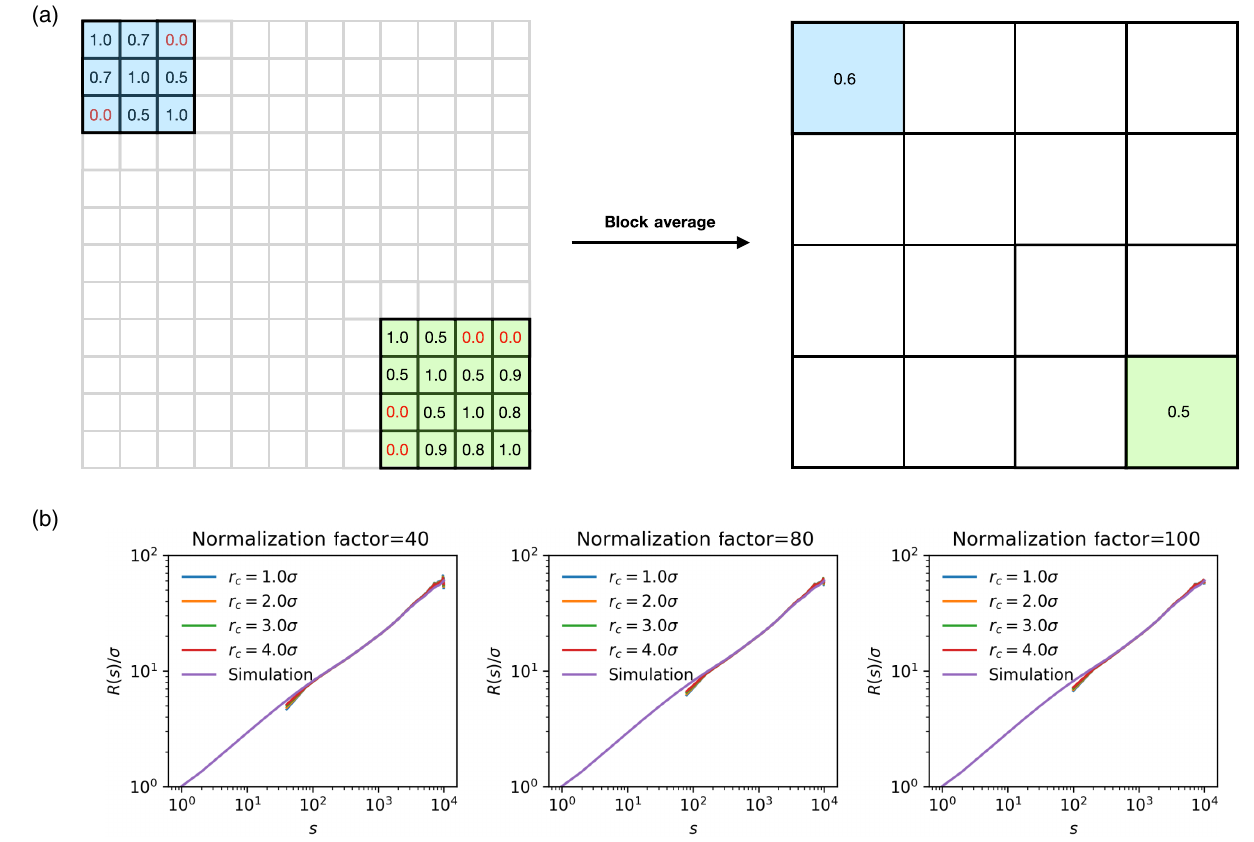
FIG. 10. (a) Illustration of block average performed on sparse contact map matrix ( h P i ). There are zero value elements in the original ¯ R h P i (matrix on the left). When constructing the distance matrix h i from such h P i , the zero value contact probability would naively imply that h ¯ r i → ∞ . To overcome this problem, we use block averages. The original N × N h P i are replaced by blocks with size n (red blocks on top left). The value of the matrix element in each block is computed as the mean value of the original elements in each block (matrix on the right). The size of the matrix is reduced from N to N=n , where n is the normalization factor. The same procedure could ¯ R ¯ R also be applied to h i . (b) Block average does not alter the information embedded in the original h P i and the calculated h i . R ð s Þ is computed for different values of the normalization factor n . The insensitivity of the results to the block averaging justifies its use in overcoming the problem of missing data points on the h P i